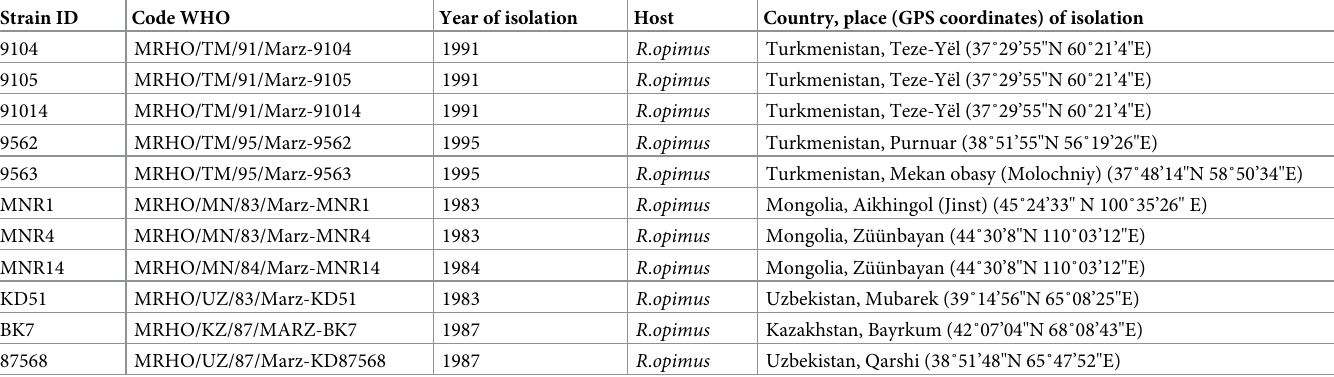
Table 1. Leishmania turanica strains analyzed in this study. Strain